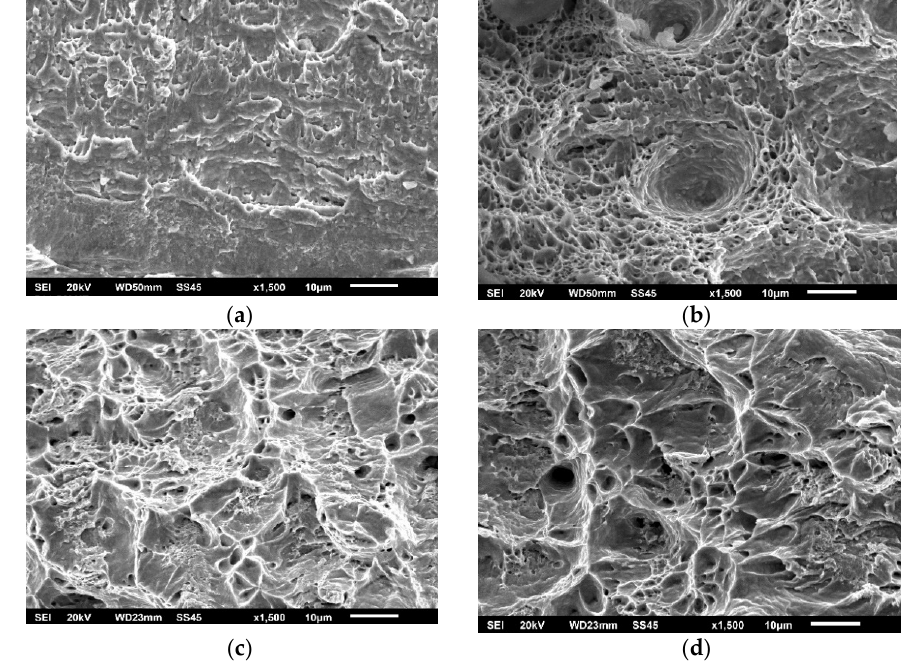
Figure 8. SA ‐ 387 Gr. 91 BM fractography upon ( a ) crack initiation, 575 °C; ( b ) crack propagation, Figure 8. SA-387 Gr. 91 BM fractography upon ( a ) crack initiation, 575 ◦ C; ( b ) crack propagation, 575 °C; ( c ) crack initiation, 20 °C; and ( d ) crack propagation, 20 °C. 575 ◦ C; ( c ) crack initiation, 20 ◦ C; and ( d ) crack propagation, 20 ◦